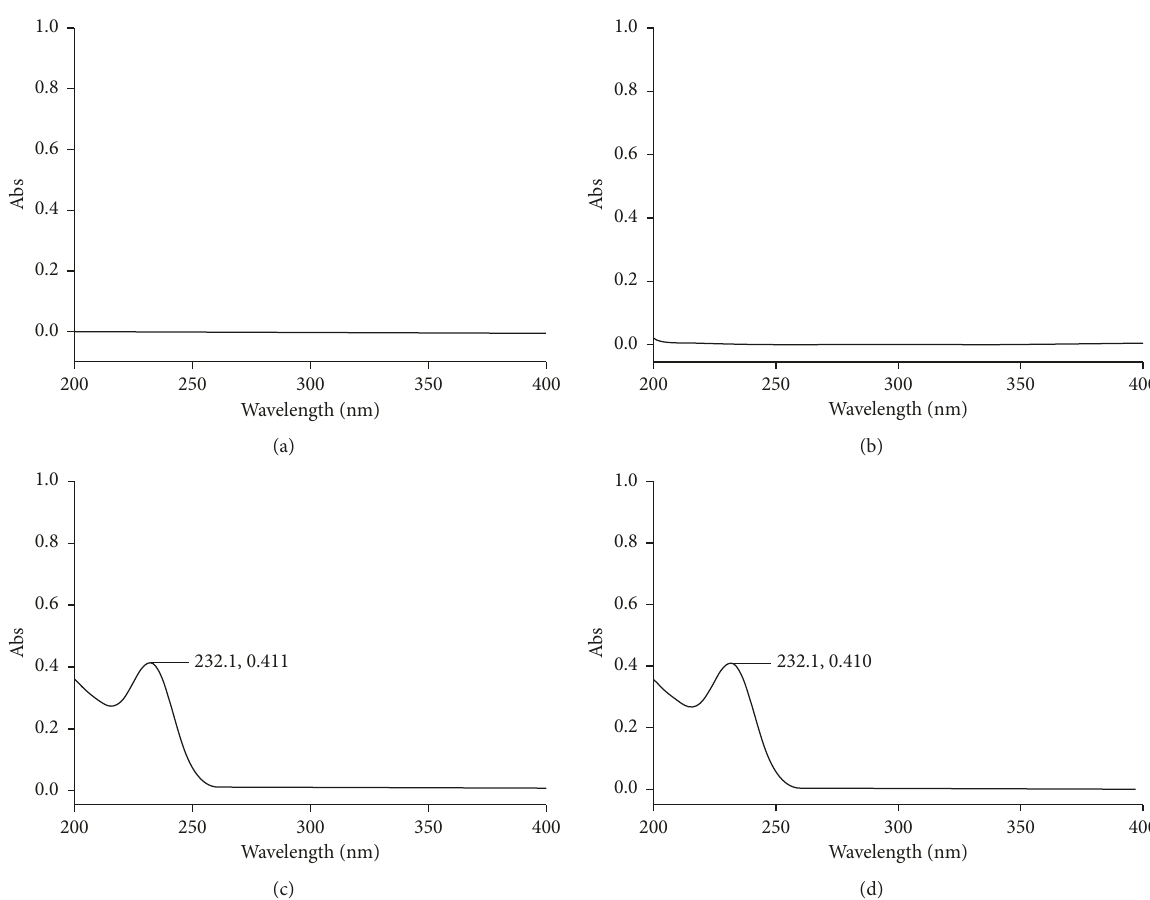
Figure 5: Specificity of UV spectrophotometric method for dissolution of metformin HCl. (a) Diluent. (b) Placebo. (c) Standard solution. (d) Sample